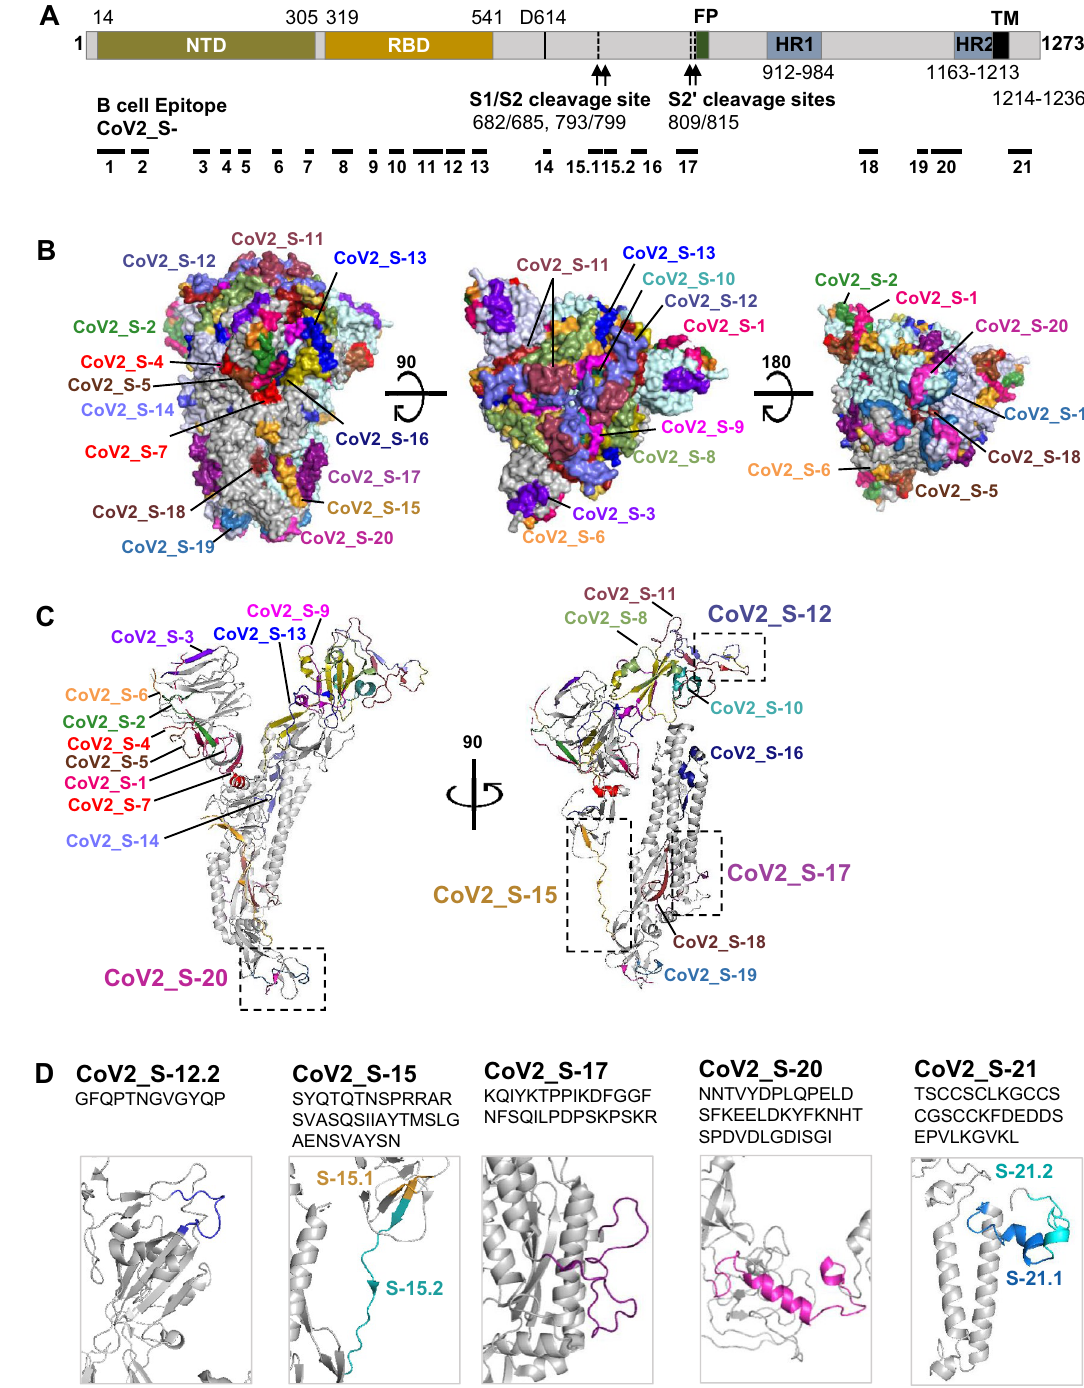
Figure 7. Schematic representation of the SARS-CoV-2 S protein and locations of linear B cell epitope on the S protein. ( A ) Schematic location of the B cell epitopes on the S protein. ( B ) Surface representation of the B cell epitopes on the SARS-CoV-2 S trimer. ( C ) Location of the B cell epitopes in the SARS-CoV-2 S monomer. ( D ) Secondary structure of the immunodominant B cell epitopes. Closed conformation of the S protein (PDB 6ZB5) is used for epitope labeling. RBD of each subunit and B cell epitopes are illustrated in different colors. Note that 3-D structure of epitopes CoV2_S-20 and CoV2_S-21 were predicted and computationally